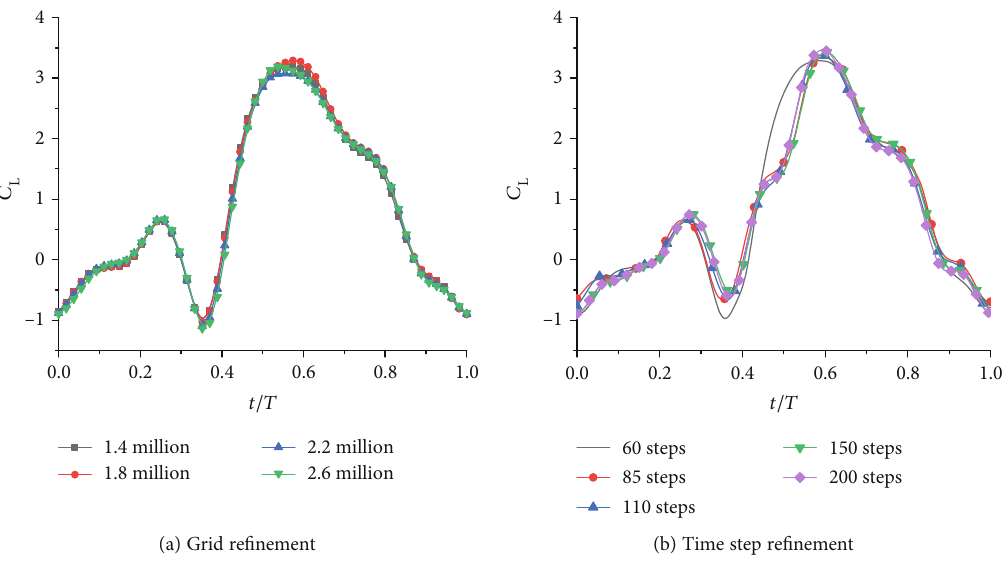
Figure 2: Grid and time step re fi